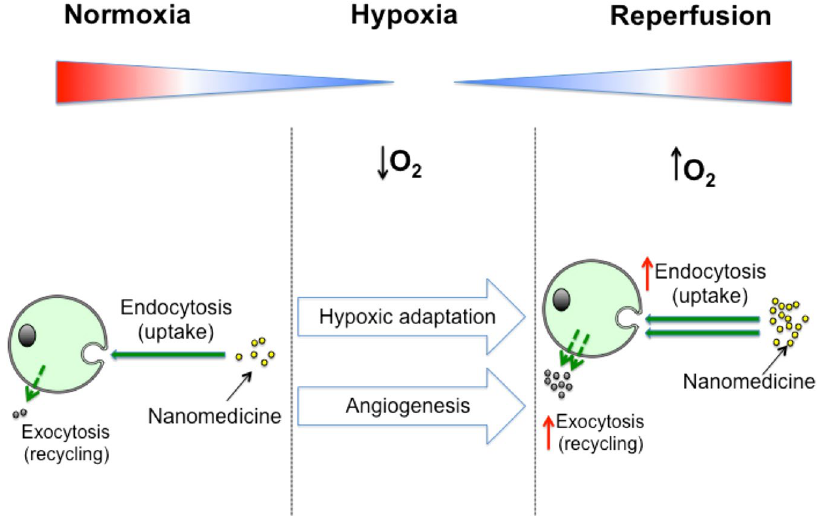
Figure 6. A schematic summary of key findings: Hypoxic conditioning of breast cancer cells increases nanomedicine uptake and